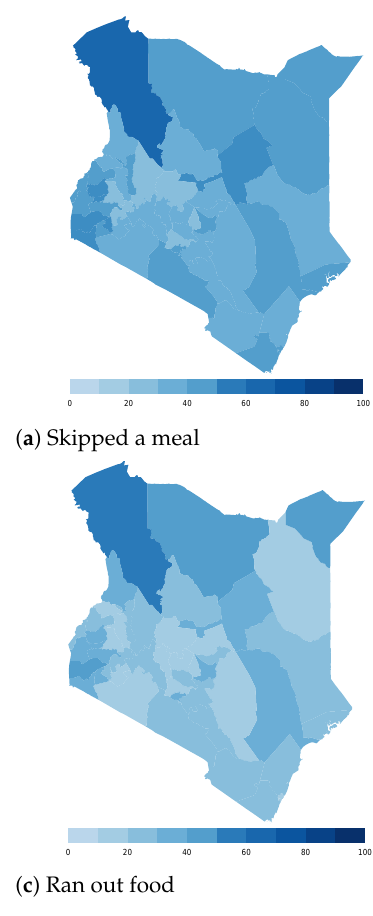
Figure 6. Kenya—share of